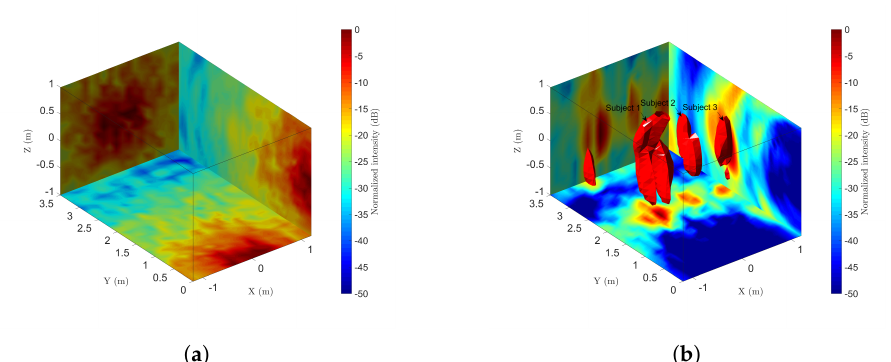
Figure 8. Through-wall detection results of radar imaging for multiple subjects. ( a ) Projection of the initial 3-D image. ( b ) Projection and CFAR detection of the fourth-order cumulant. Table 3. Localization results (in meters) of multiple subjects in line-of-sight and through-wall cases. Truth (m) Estimation (m) Error (m) Line-of-sight